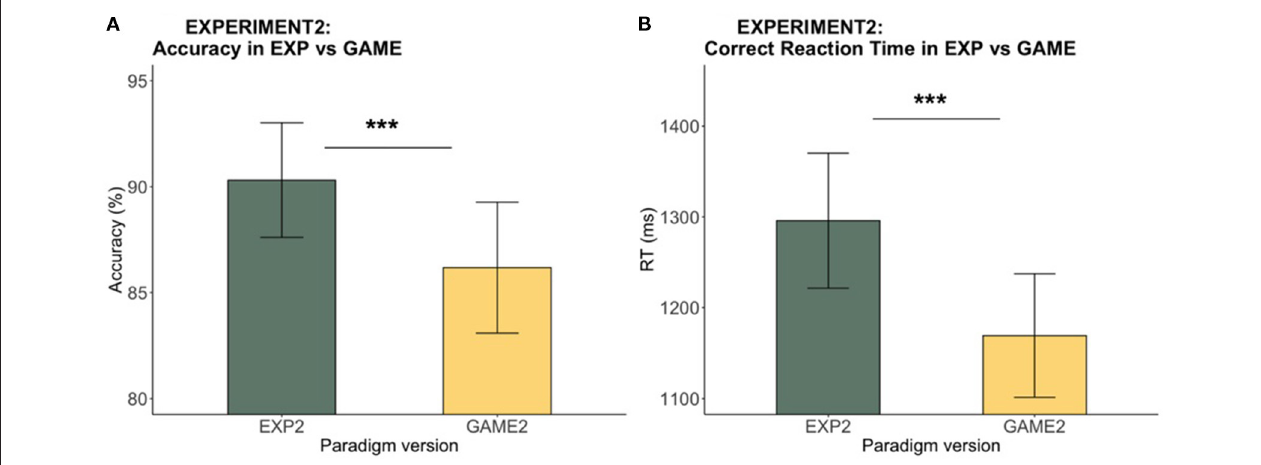
FIGURE 6 | Experiment 2: Experiment vs. game accuracy and RT. Figure shows (A) the mean accuracy, and (B) the mean RTs, across participants. The error bars show 95% confidence intervals. Accuracy of the game was lower, and RT of the game was faster, as compared to the experiment. A speed-accuracy tradeoff was observed between the two versions of the paradigm (*** p <